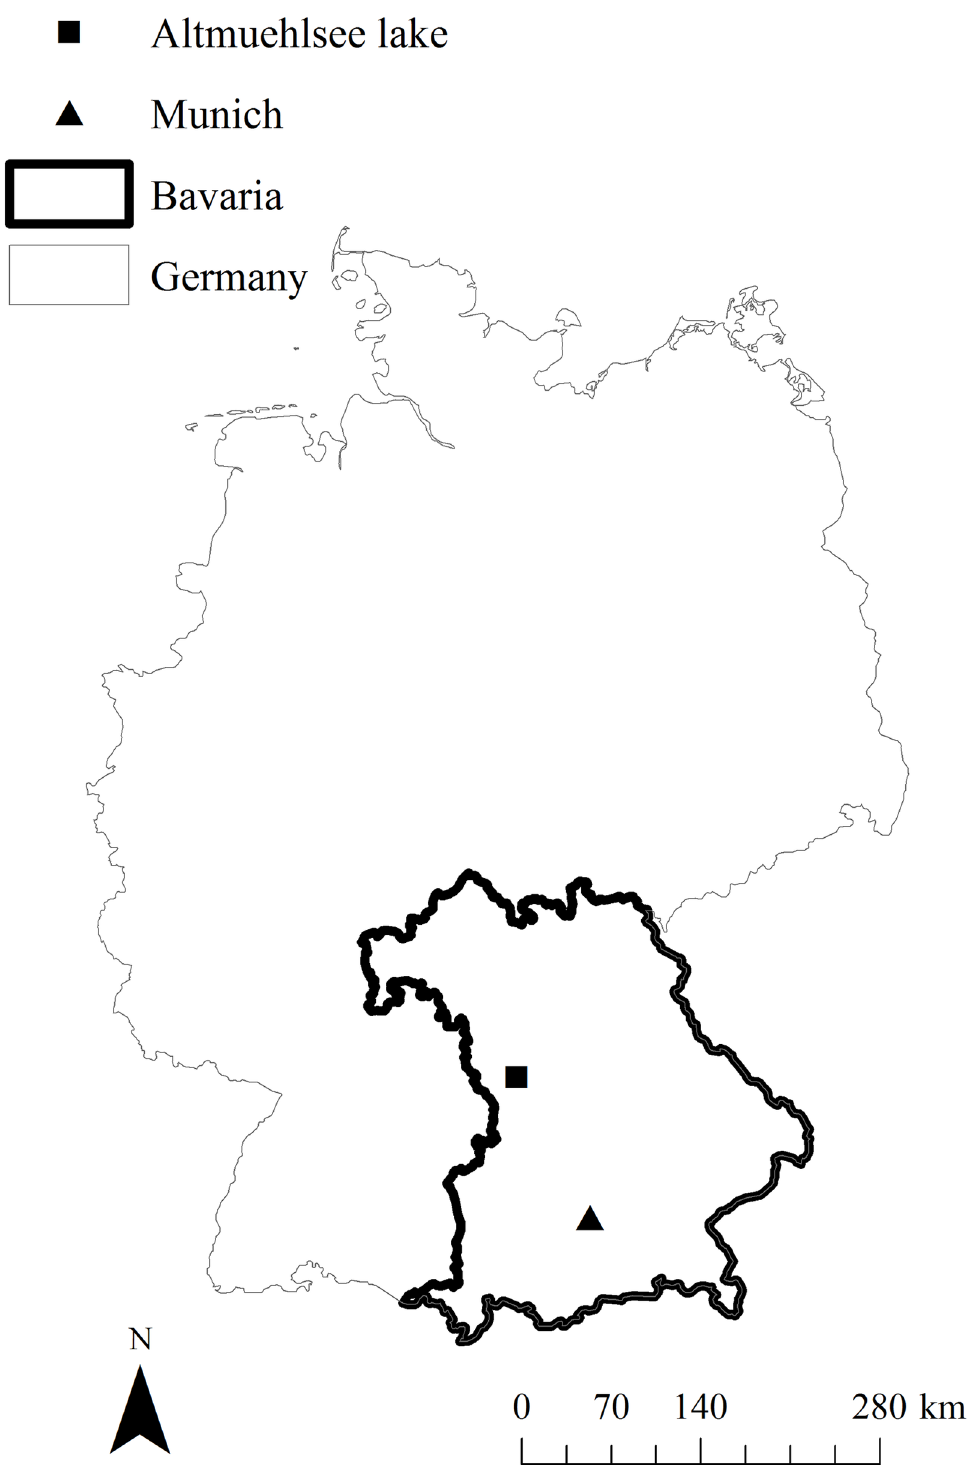
Fig 1. Map of Germany showing the position of the study area. Made with Natural Earth. Free vector and raster map data @ naturalearthdata.com.